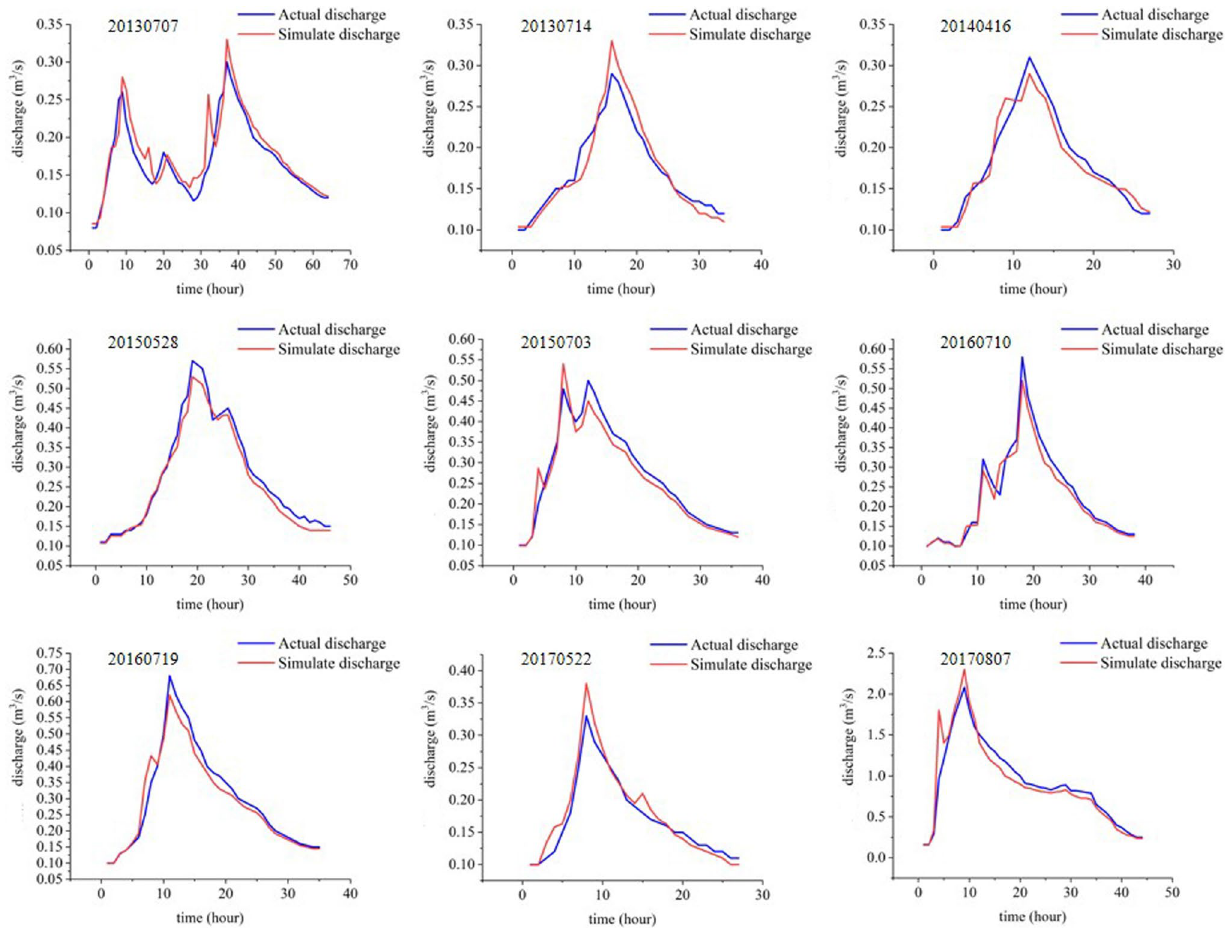
Fig. 10 Comparison of measured and simulated values